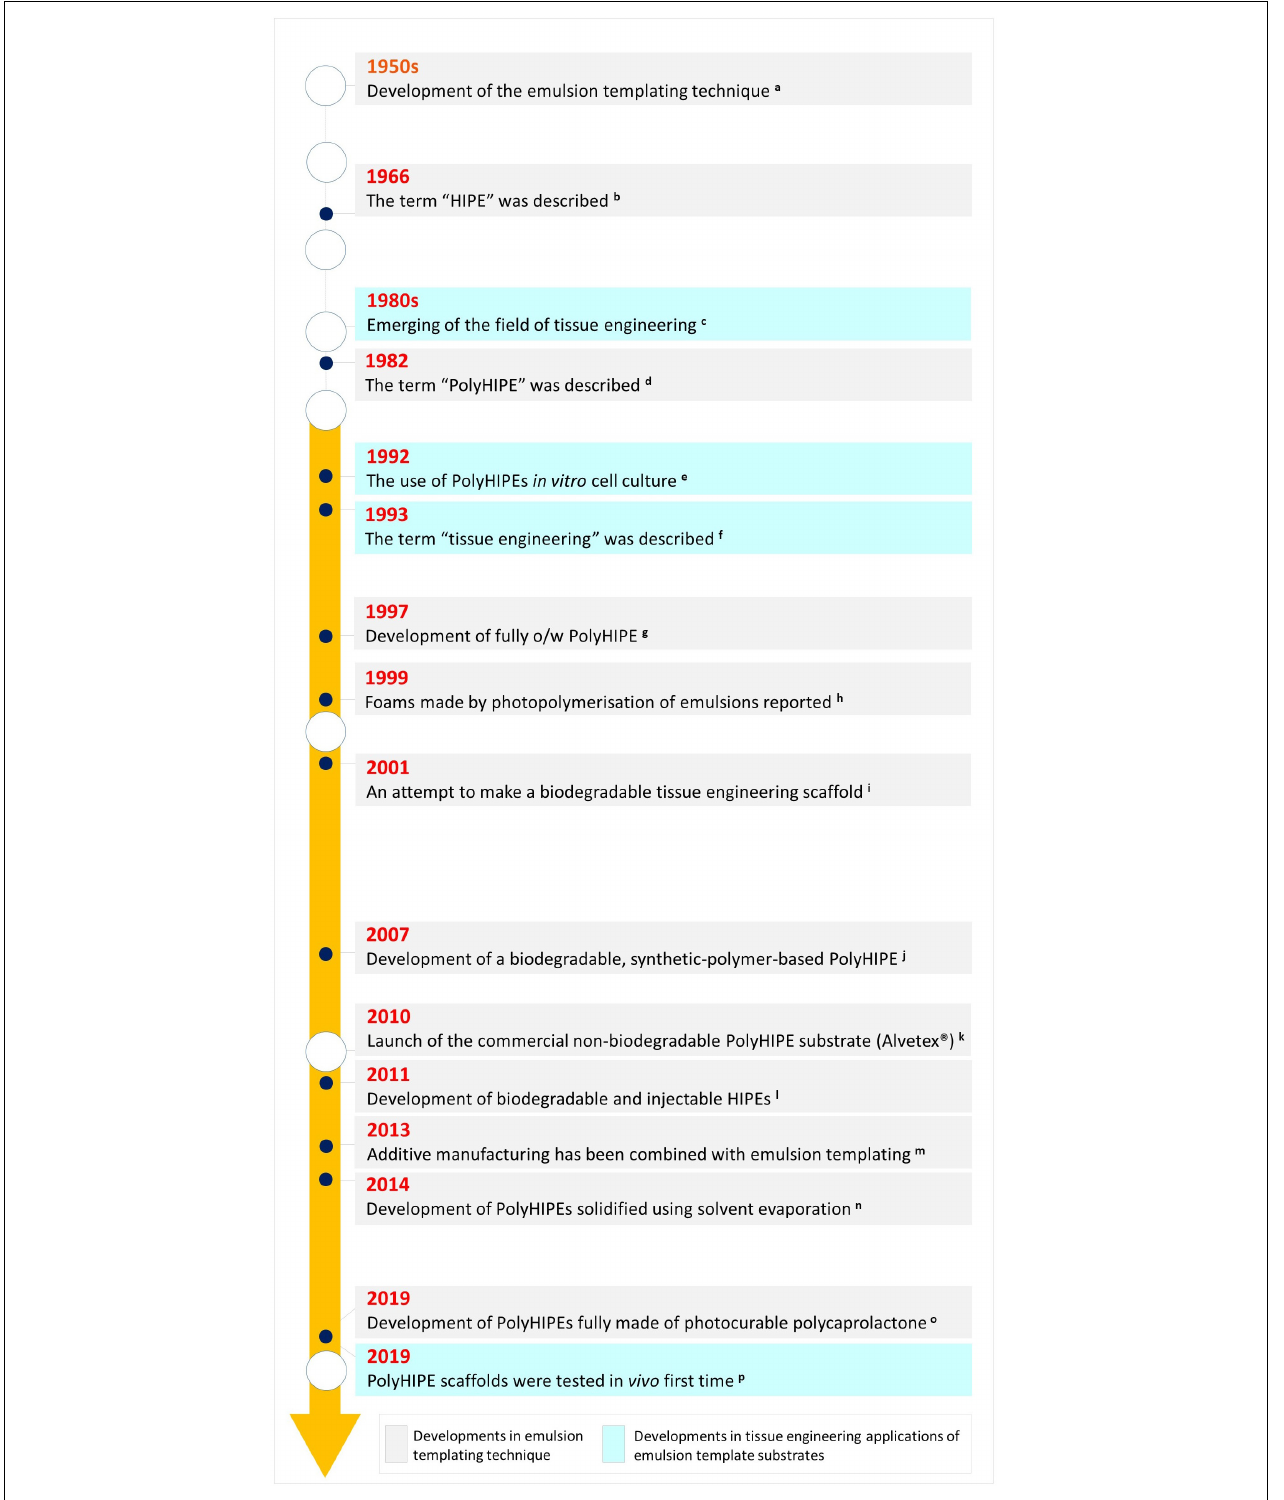
FIGURE 3 | Historical landmarks in emulsion templating in terms of material development and its use in tissue engineering applications [a. (Guenther, 1959), b. (Lissant, 1966), c. (Vacanti, 2006; Meyer, 2009), d. (Barby and Haq, 1985), e. (Lee et al., 1992a,b), f. (Langer and Vacanti, 1993), g. (Kitagawa, 2001), h. (Thunhorst et al., 2003), i. (Busby et al., 2001), j. (Christenson et al., 2007), k. (Padbury, 2019), l. (Moglia et al., 2011), m. (Johnson et al., 2013; Sušec et al., 2013), n. (Hu et al., 2014a), o. (Aldemir Dikici et al., 2019b), p. (Aldemir Dikici et al., 2019a)].